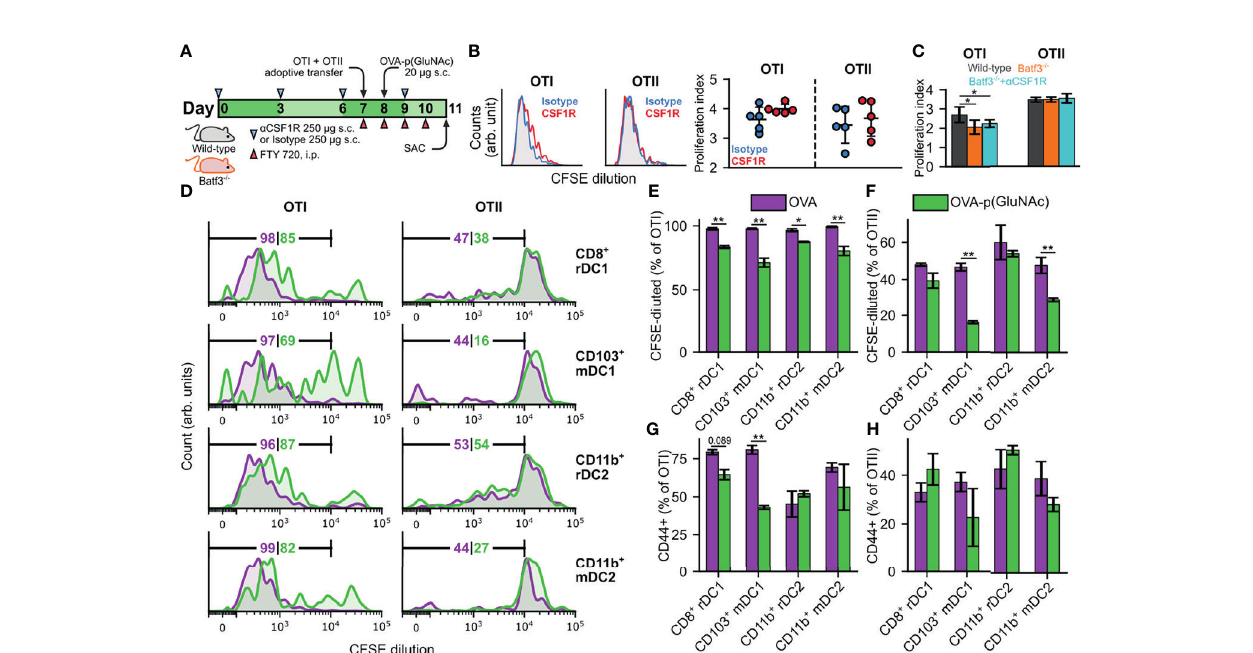
FIGURE 5 | (A) CD45.2 + mice of wild-type (WT) or Batf3 -/- genotype were treated s.c. in all four hocks with 250 m g of a CSF1R or an isotype IgG2a control on days 0, 3, 6 and 9. On day 7, mice received an adoptive transfer of CFSE-labeled OTI CD8 + T and OTII CD4 + T cells via i.v. injection, followed by a s.c. administration of 20 m g OVA-p(GluNAc) on day 8, and daily i.p. injections of FTY 720 inhibitor starting on day 7. On day 11, mice were sacri fi ced and the dLNs and spleen were examined for OTI and OTII proliferation. (B) (Left) Representative fl ow cytometry histograms of the CFSE dilution undergone by OTI CD8 + T (left) and OTII CD4 + T (right) cells in the dLNs of WT mice in the isotype control (blue) and a CSF1R (red) conditions. (Right) Quantitative analysis of the OTI and OTII T cell proliferation index in dLNs of WT mice treated as described above. (C) Quantitative analysis of the OTI and OTII T cell proliferation index in dLNs of Batf3 -/- mice and WT mice treated as described above. (D – H) DCs were FACS sorted from s.c. LNs (axillary, brachial, inguinal, popliteal, cervical) of WT mice into four populations: CD8 + resident (CD8 + rDC1), CD103 + migratory (CD103 + mDC1), CD11b + resident (CD11b + rDC2) and CD11b + migratory (CD11b + mDC2), and stimulated in vitro in a 1:1 ratio with CFSE-labeled OTI CD8 + T and OTII CD4 + T cells in the presence of 2 m M of OVA or OVA-p(GluNAc). 3 days later, the OTI and OTII T cells were analyzed for proliferation and activation (CD44 + ). (D) Representative fl ow cytometry histograms of the CFSE dilution (numbers indicate percent proliferated) undergone by OTI CD8 + T (left) and OTII CD4 + T (right) cells induced by each DC subset in the OVA (purple) and OVA-p(GluNAc) (green) groups. (E) Quantitative analysis of the OTI CD8 + T proliferation. (F) Quantitative analysis of the OTII CD4 + T proliferation. (G) CD44 + OTI CD8 + T cells. (H) CD44 + OTII CD4 + T cells. The graphs show means ± SD, n = 5. *p ≤ 0.05, **p ≤ 0.01 by unpaired Student ’ s T test in B, one-way ANOVA using Tukey ’ s post hoc test in C, and two-way ANOVA using Sidak ’ s post hoc test in (E – H)